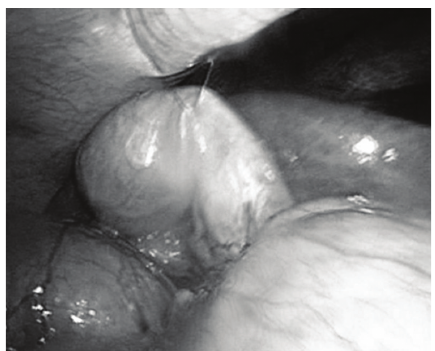
Figure 1: Hanging suture place at gallbladder fundus.